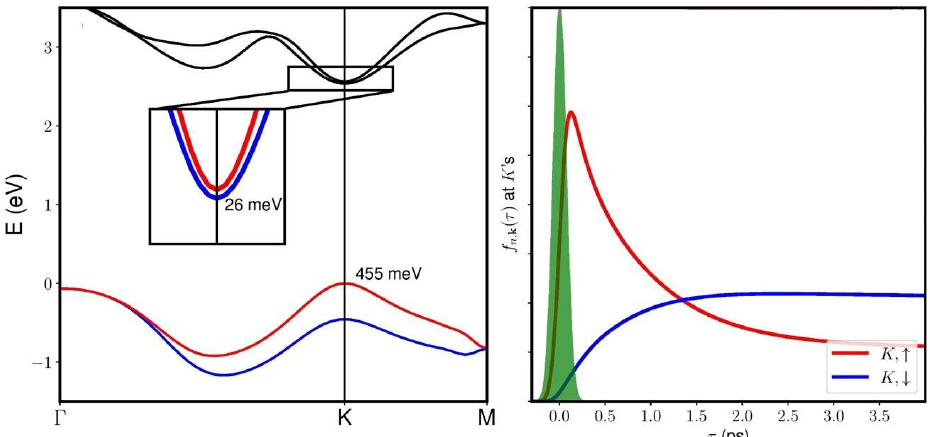
Fig. 2. (Left panel) Calculated band structure of 1L-WS 2 . The spin-orbit splitting of the valence band in the K point is in good agreement with the experimental value. In the inset the calculated splitting of the CB (i.e. 26 meV) is reported on an enlarged scale. (Right panel) Temporal evolution of the number of carriers in the upper and lower CB state (respectively K, ↑ and K,↓) around the K point after excitation by a 100 fs pump pulse (green curve) centered around the A